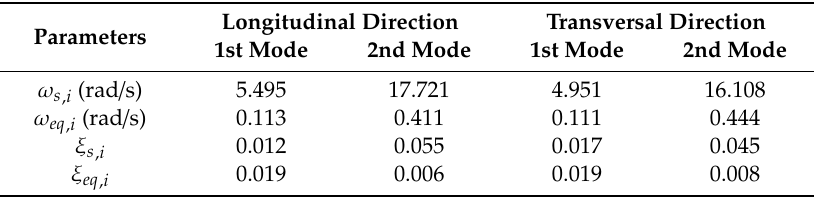
Table 3. The estimated equivalent natural frequencies and equivalent damping ratios provided by oil dampers. The corresponding parameters of the building itself also shown.